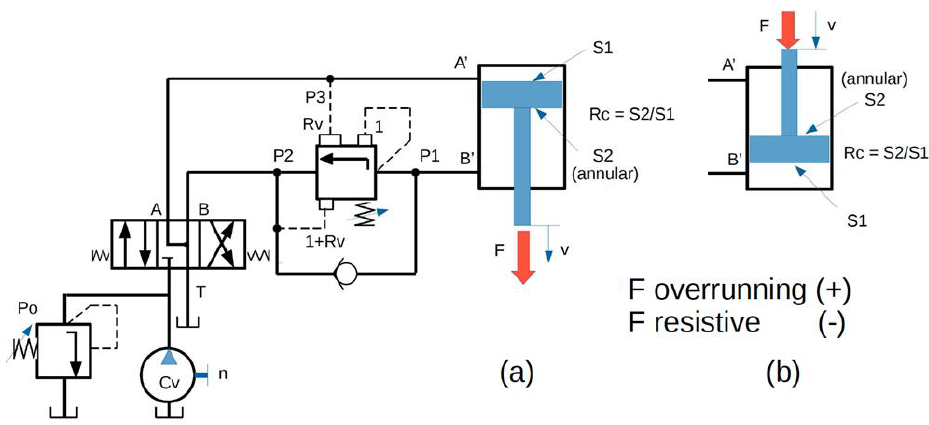
Figure 2. Typical application hydraulic circuit. ( a ) LHV valve is connected to the chamber on the rod side; ( b ) LHV valve is connected to the chamber on the piston side.